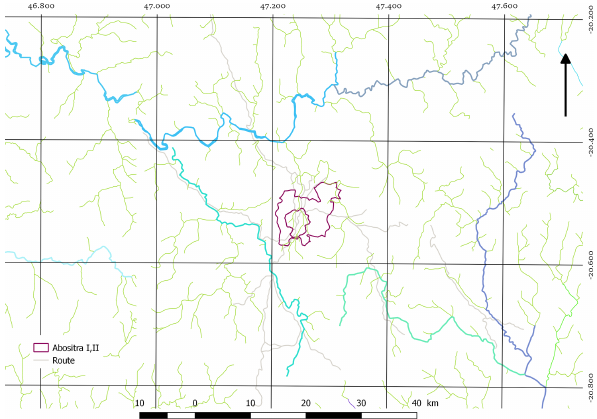
Figure 2. Aperçu hydrographique du site d’étude (Source : BD 100 FTM, Realisation : Randriamifidison, 2019).